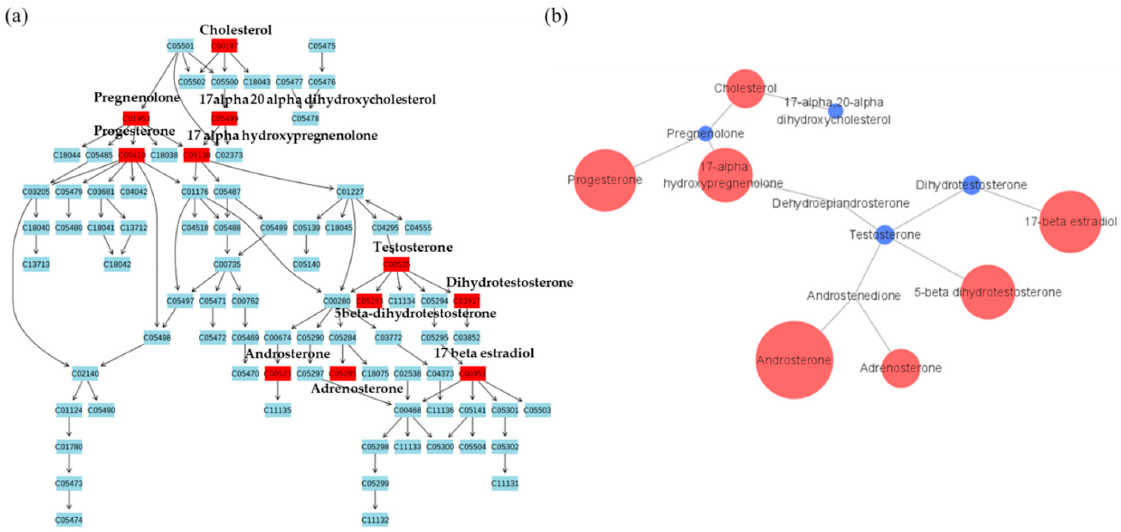
Figure 5. Metabolites with differences between male groups in steroid metabolic pathway. ( a ) Metabolites in red indicate significant differences between groups and ( b ) the pathway mapping of metabolites and relative quantitation between male pattern baldness patients and male controls. The larger the circle, the larger the relative quantitative value. Red circles indicate higher metabolite concentrations in the patient group and blue circles indicate higher metabolite concentrations in the control group.